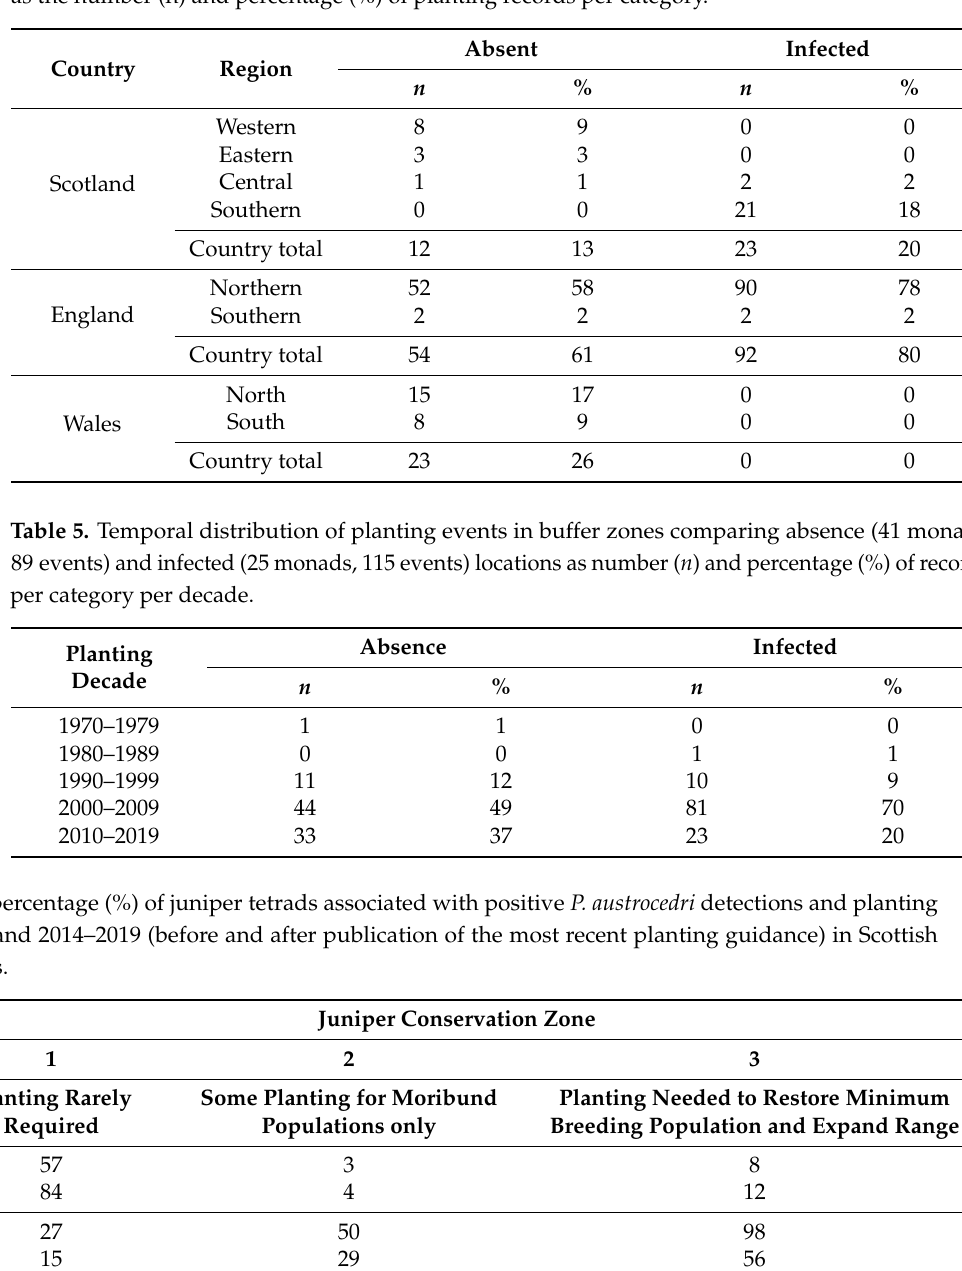
Table 4. Geographic distribution of planting records in buffer zones associated with absence (41 monads, 89 planting events) and infected (25 monads, 115 planting events) locations shown as the number (n) and percentage (%) of planting records per category.